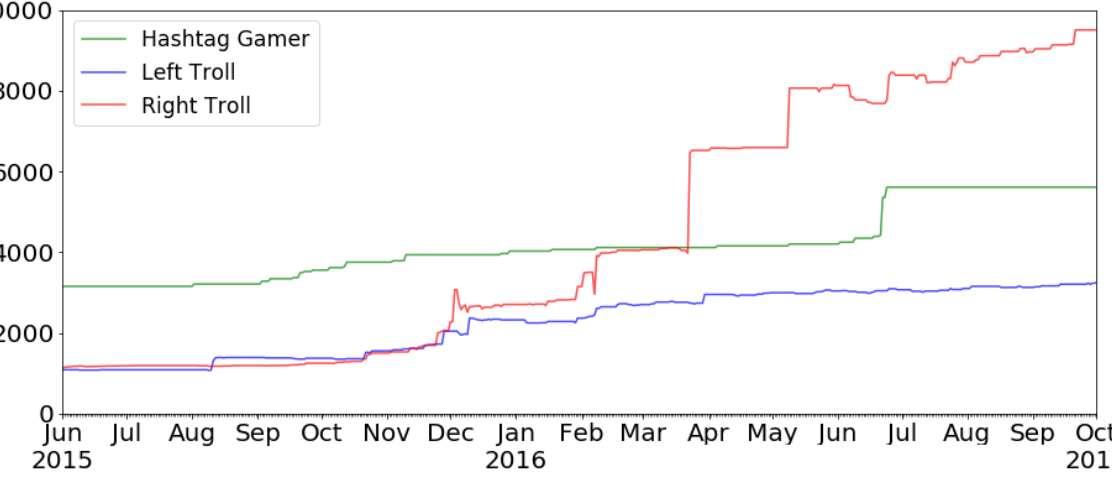
Figure 3. Approximate Mean Followers for Active IRA Accounts of the Indicated Type . Finding 4: In Sep-Oct, 2016, the mix for Left and Right Trolls shifts again to over 90 percent external